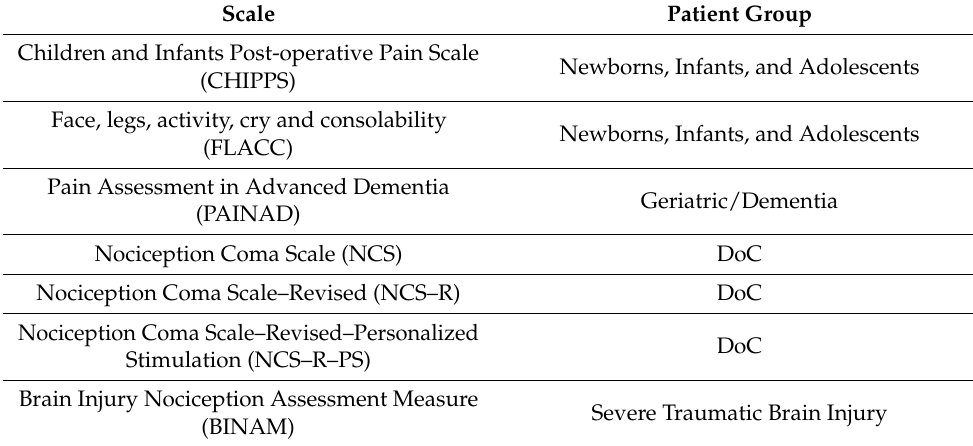
Table 2. Pain Assessment Tools in Non-Communicative Patients. Scale Patient Group Children and Infants Post-operative Pain Scale Newborns, Infants, and Adolescents (CHIPPS) Face, legs, activity, cry and consolability Newborns, Infants, and Adolescents (FLACC) Pain Assessment in Advanced Dementia (PAINAD)